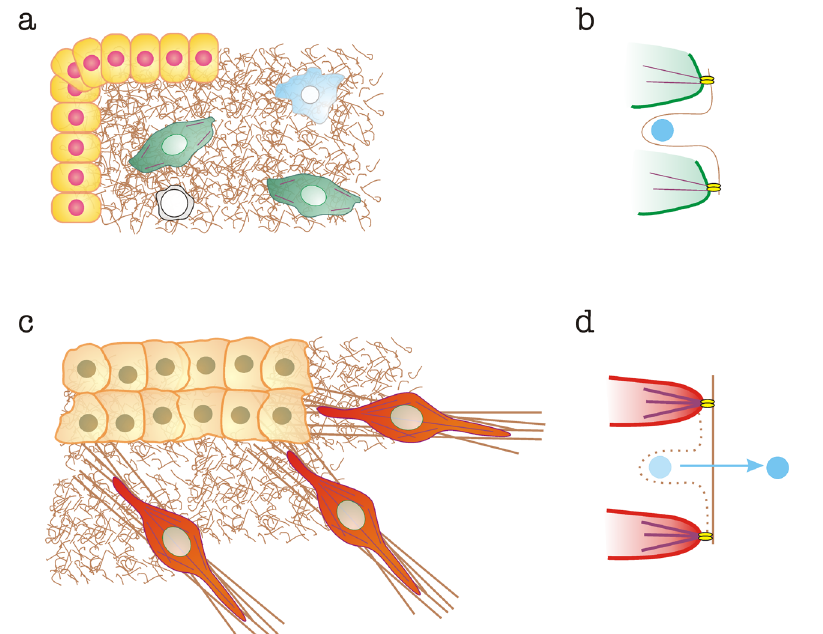
Figure 1. Alterations to the organization of the ECM and mechanical release of matrix-bound TGF-β mediated by CAFs. a) Normal tissue. Epithelial cells are shown in yellow, normal fibroblasts in green, macrophages in blue and T cells in white. Normal matrices are represented as brown “curly” fibers; b) curly fibers contain cryptic sites that bind TGF-β (shown in light blue) preventing its interaction with membrane-bound TGF-β receptors. Interaction with fibroblast integrins (bright yellow) linked to normal actin bundles (in purple) does not exert sufficient force to destroy the cryptic binding site and release TGF-β; c) tumor microenvironment, containing a carcinoma mass (light orange) and CAFs (red). Some of the matrix is bundled (brown straight lines); d) CAF integrins linked to SMA-enhanced bundles pull on the matrix, stretching it and eliminating cryptic binding sites, thereby releasing TGF-β, which is free to interact with TGF-β